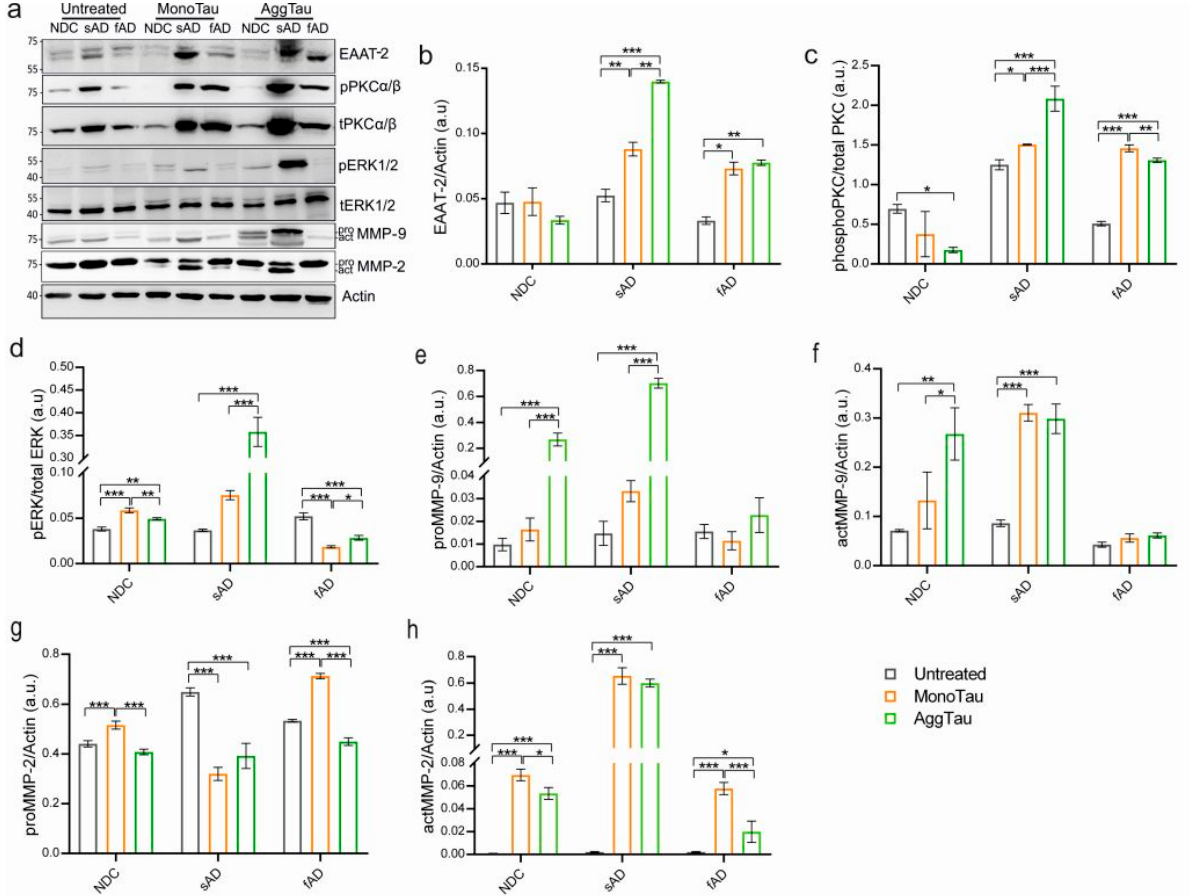
Figure 5. Deregulation of astrocytic protein upon exposure to tau. ( a ) Immunoblots using antibody against proteins EAAT-2, phosphoPKC II (pPKC α / β ), total PKC II (tPKC α / β ), phosphoERK1/2 (pERK1/2), total ERK1/2 (tERK1/2), pro- and active MMP-9 and MMP-2. Actin was used as loading control. Graph showing levels of ( b ) EAAT-2, ( c ) phospho/total PKC α / β , ( d ) phospho/total ERK1/2, ( e ) pro-MMP9, ( f ) active-MMP9, ( g ) pro-MMP2, and ( h ) active-MMP2 in astrocytes between the